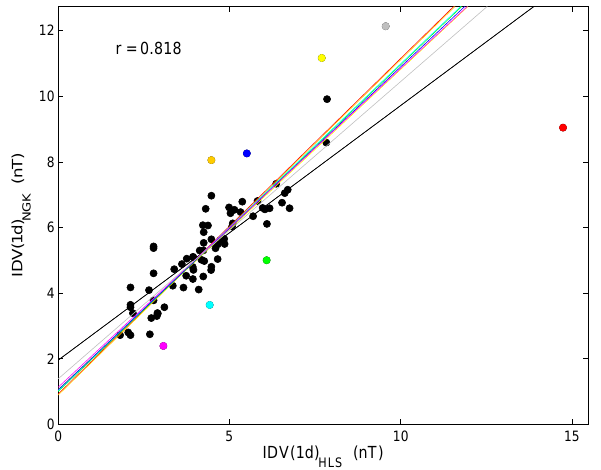
Fig. 6. Scatter plot of Bartels rotation interval means of IDV(1d) values from Helsinki and Niemegk, IDV(1d) HLS and IDV(1d) NGK respectively, for 1890–1897. The coloured dots show outliers re- moved in the order red, orange, yellow, green, cyan, blue, mauve, and grey. The black line is the regression for no outlier removal and the red line the regression after removal of the red point, and so on. The regression was considered not greatly influenced by outliers af- ter N r = 4 outliers were removed out of the total of 80 available data points. The correlation coefficient prior to removals was r = 0 . 818.